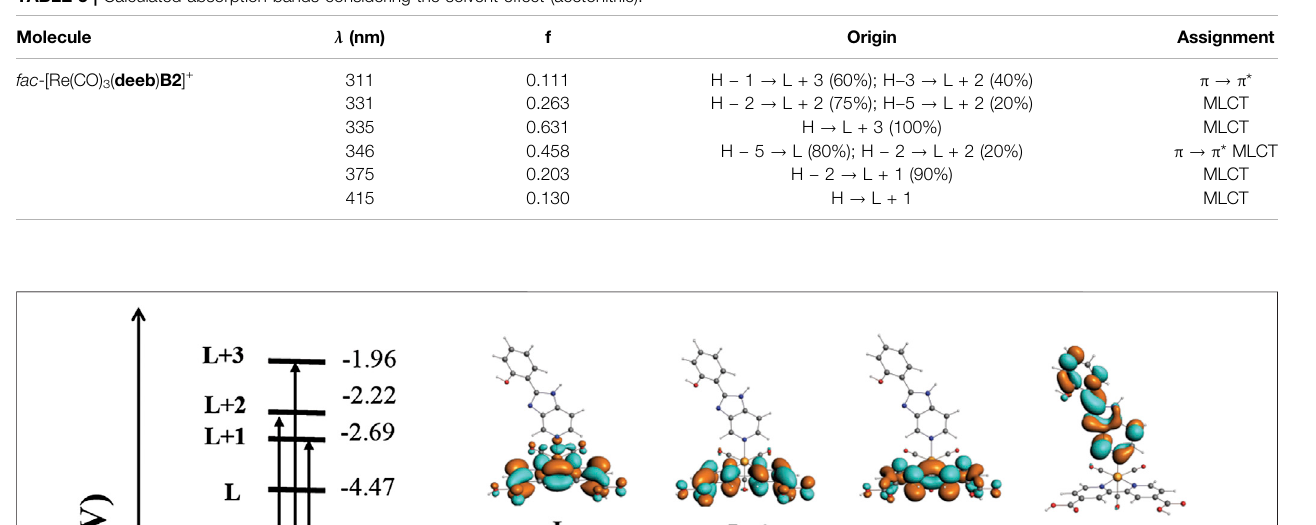
Frontiers in Chemistry |